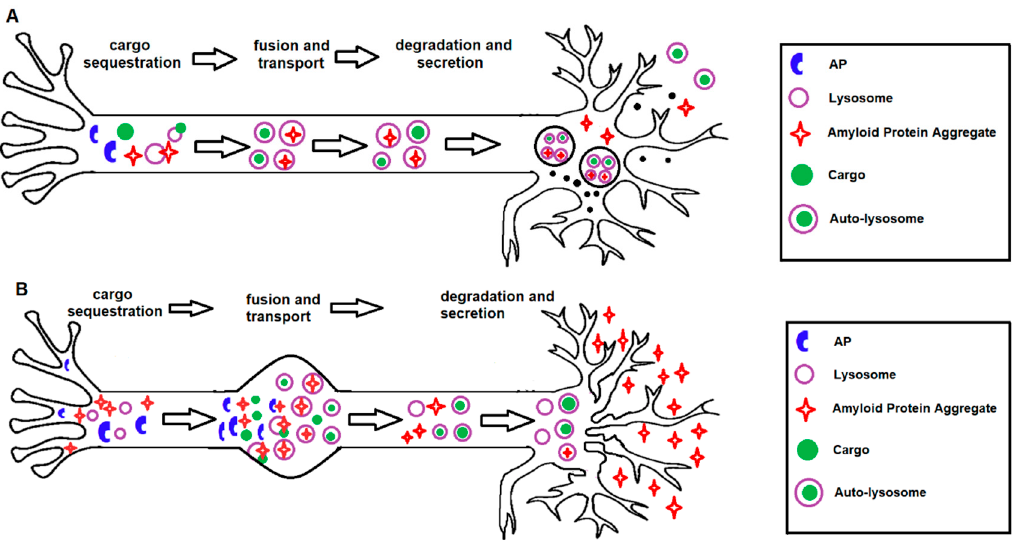
Figure 3. Protective and detrimental effects of autophagy activation in AD. ( A ) Under normal conditions, autophagy activation serves as a protective mechanism in healthy neurons with functional lysosomal clearance, by regulating the homeostasis of the axon terminal, membrane recycling, presynaptic function and removal of neurotoxins. ( B ) Under pathogenic conditions, as seen in human AD brains, autophagy activation can become detrimental in neurons with pre-existing protein aggregation and dysfunctional lysosomal clearance. In addition, autophagy activation could potentially lead to increased accumulation of immature autophagosomes, impaired autophagosome– lysosome fusion or may lead to the excessive degradation of essential organelles, self-digestion and neuronal death.